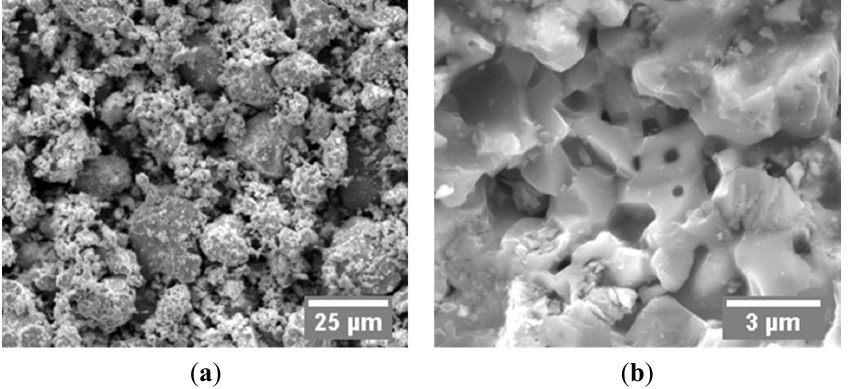
Figure 1. SEM images of as received ZrC powder: ( a ) 1000×; ( b ) 10000×. Table 1. Properties and compositions of as received ZrC powder.